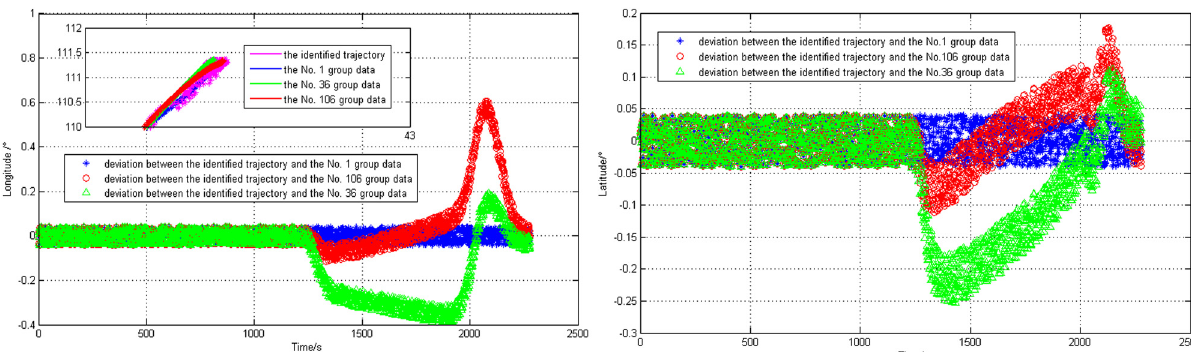
Figure 13: Sub - satellite point